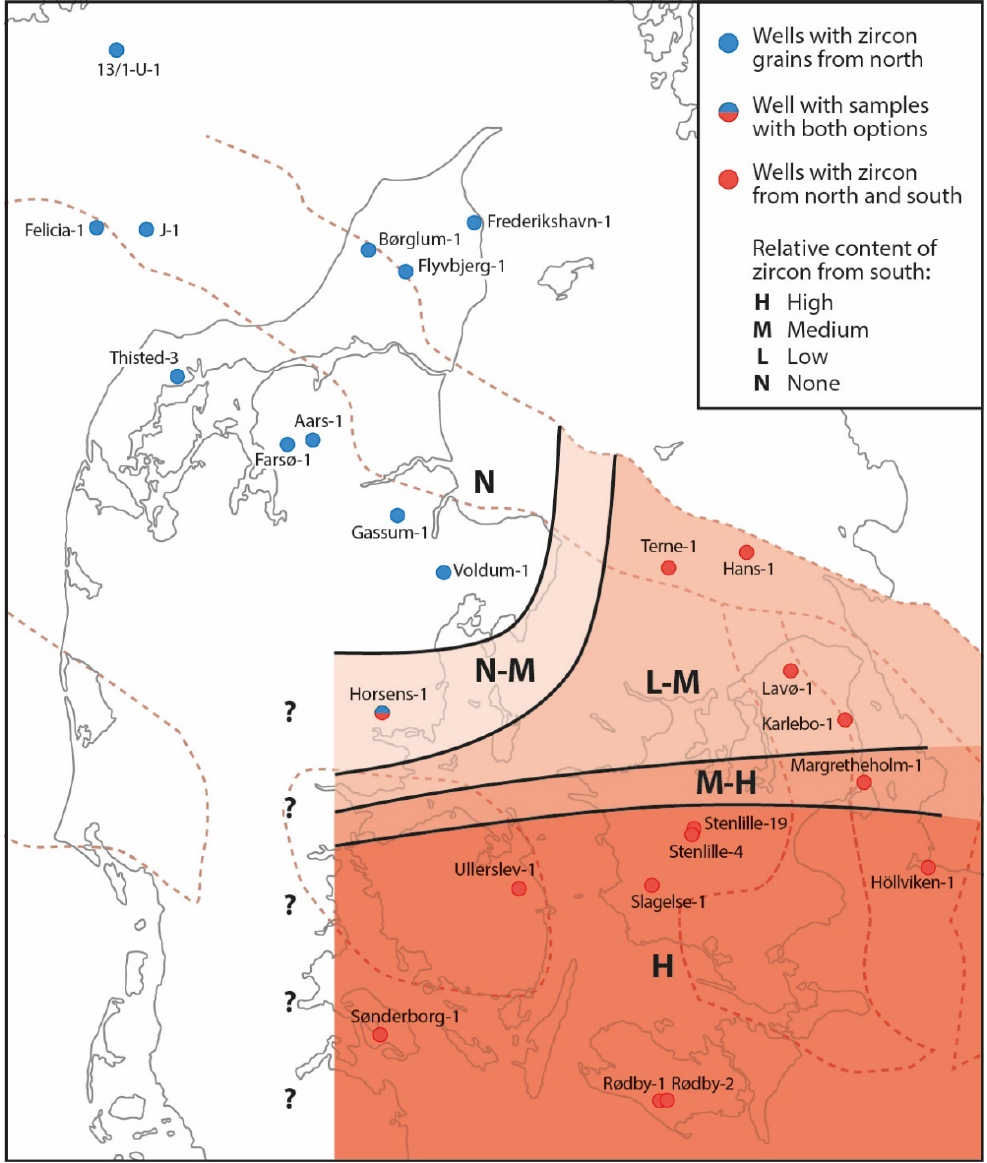
Figure 10. Contour map of the content of Variscan zircon grains in the Gassum Formation. The relative content of Variscan zircon grains in each sample has been classified as high, medium, low or none based on a qualitative estimation. Only one of the three samples from the Horsens-1 well contains Variscan zircon grains. It is evident that the zircon grains with Variscan ages have been supplied from the south or southeast, which is in accordance with the direction to the Variscan Orogen.